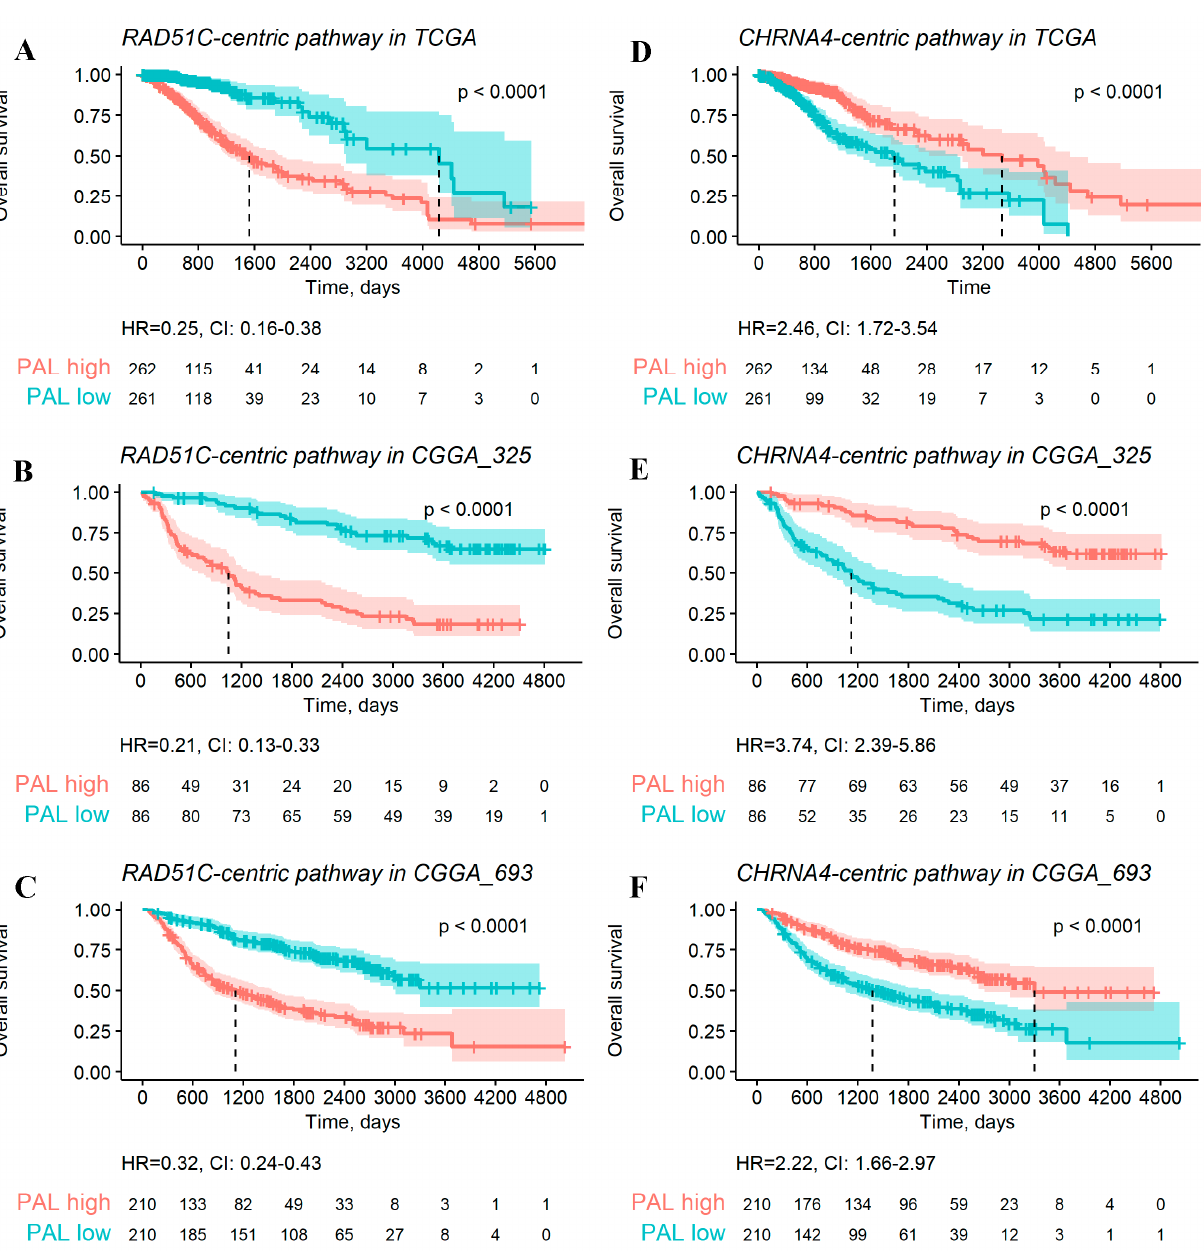
Figure 7. Examples of the negative ( RAD51C pathway, panels ( A – C )) and positive ( CHRNA4 pathway, panels ( D – F )) OS gene-centric pathway biomarkers of LGG identified for TCGA ( A , D ), CGGA_325 ( B , E ), and CGGA_693 ( C , F ) datasets. “High” and “low” levels were defined relative to a median pathway activation level. Hazard ratio (HR) and its confidence interval (CI) are shown for every analysis.